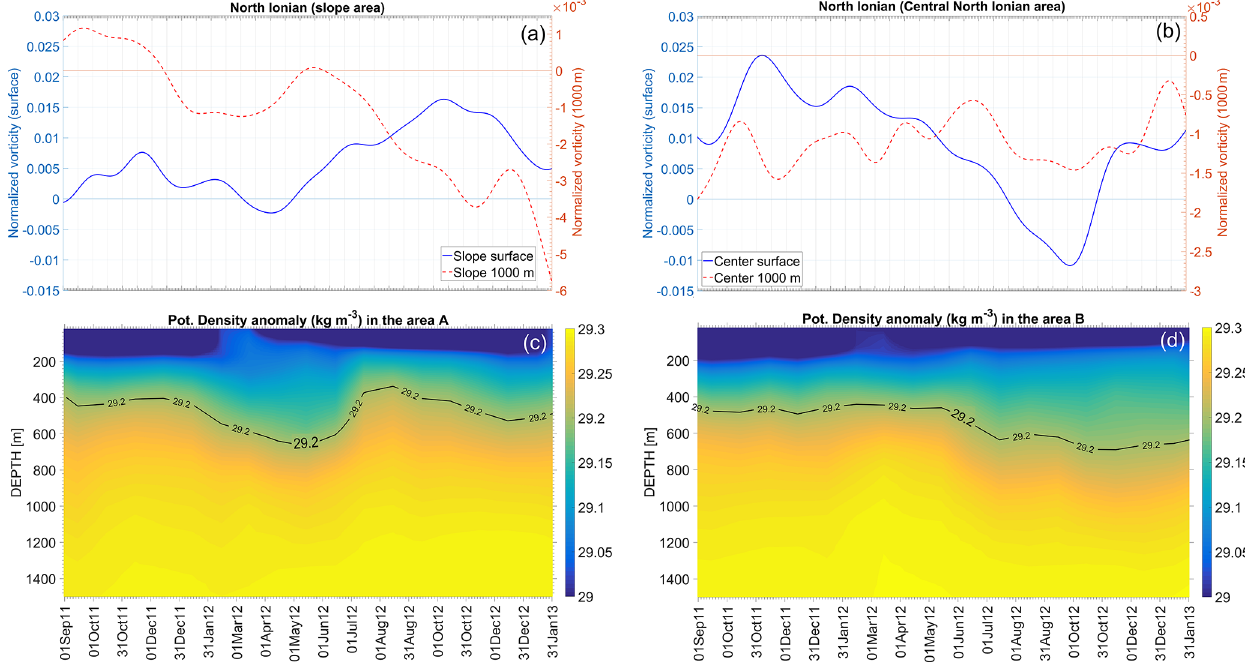
Figure 12. The Ionian Sea, continental slope (area A) and center (deep open sea; area B) (see Fig. 1): temporal evolution of the vorticity normalized by the Coriolis parameter f (10 − 4 s − 1 ) at the surface and at 1000m depth over the slope (a) and in the center (b) . A Hovmöller diagram of the potential density anomaly over the slope (c) and in the center (d)